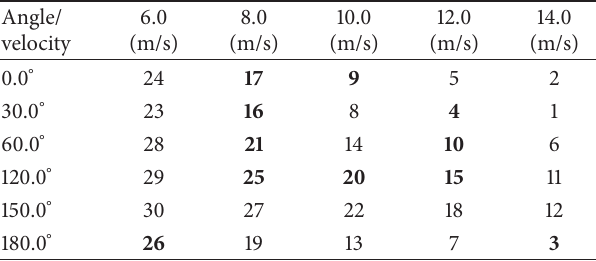
Table 5: Wind load ranking magnitude for conventional panels. Number 1 indicates the highest possible wind force and number 30 the smallest one. Bold font values indicate that the wind force ranking has been affected in comparison to panels with holes.